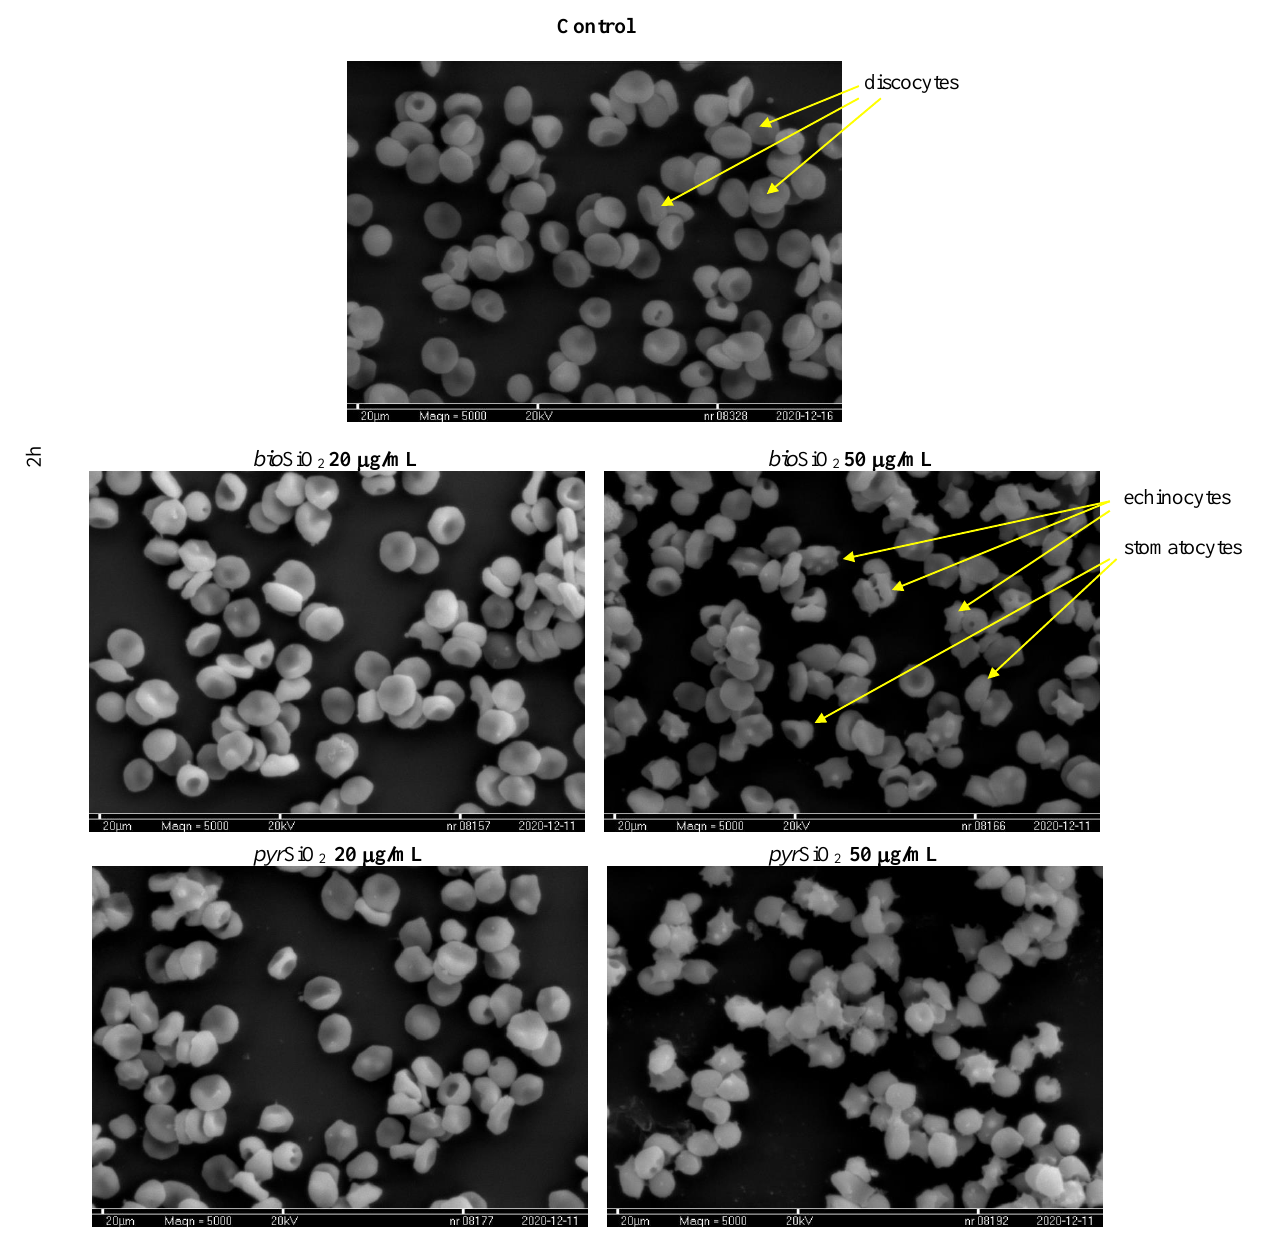
Figure 12. Change of erythrocyte’s shape after treatment red blood cells with different concentration of SiO 2 and 2 h incubation: control, bio SiO 2 20 µ g/mL, bio SiO 2 50 µ g/mL, pyr SiO 2 20 µ g/mL, pyr SiO 2 50 µ g/mL. The scale bar corresponds to 20 µ